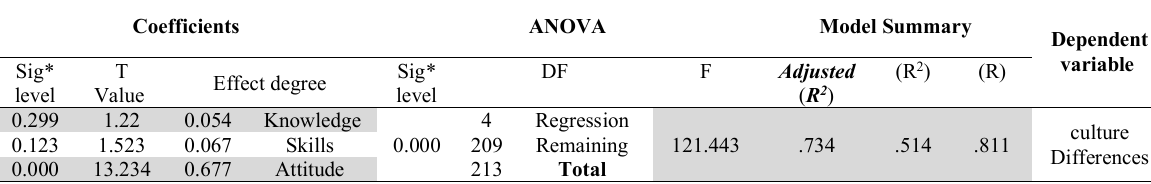
The summary of testing the second hypothesis based on regression